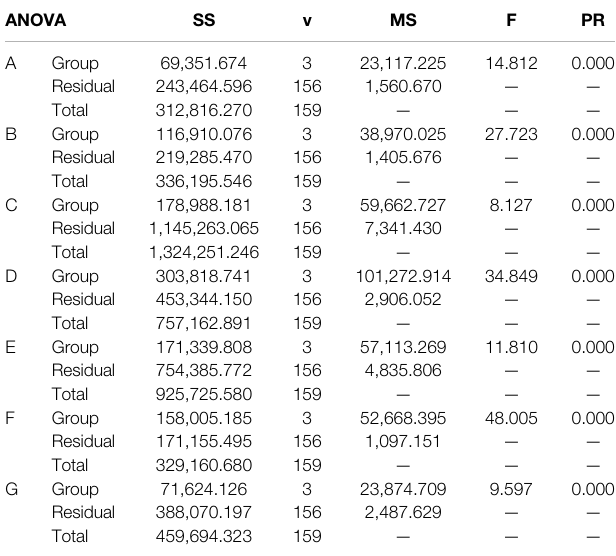
TABLE 3 | Results of one-way analysis of variance of sacral bone mineral density.